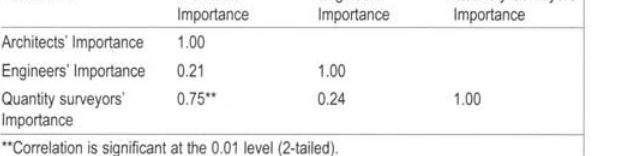
Table 5: Spearman rank correlation coefficients of consultants' importance Percentage rank agreement factor